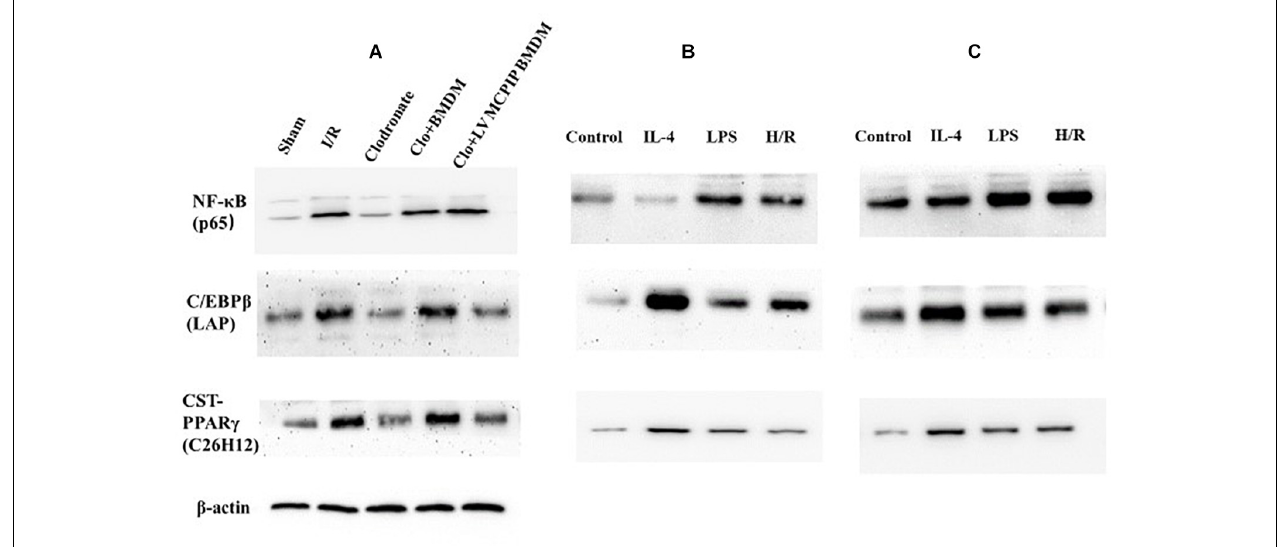
FIGURE 6 | Protein levels of NF- κ B p65 and C/EBP β and PPAR γ were determined by Western blotting analysis. (A) Representative immunoblot for these signaling proteins in mice. (B,C) corresponding protein levels in BMDM and BMDM with MCPIP deficiency ex vivo